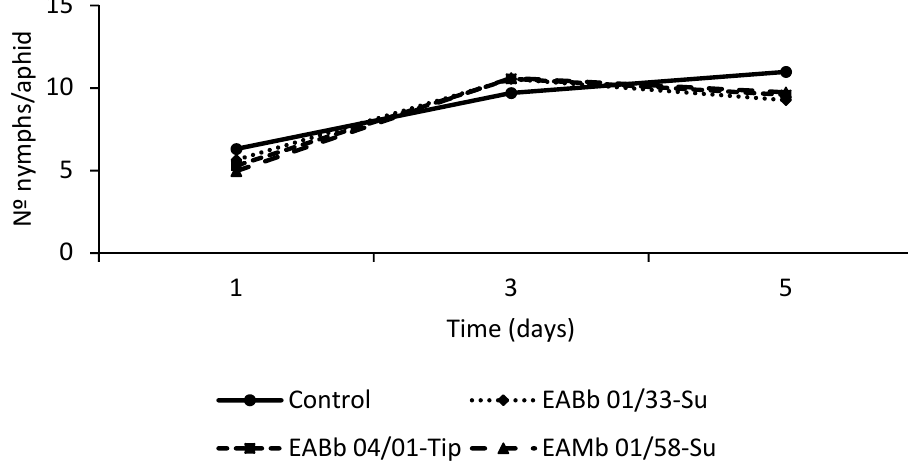
Figure 2. Per capita aphid fecundity over time (5 days) after aphid exposure to a sprayed leaf (with both surface conidia and endophytic colonization by one of three fungal isolates or the control). Evaluation began (day 1 on graph) 72 hours after leaves had been sprayed. Data represents the average of two